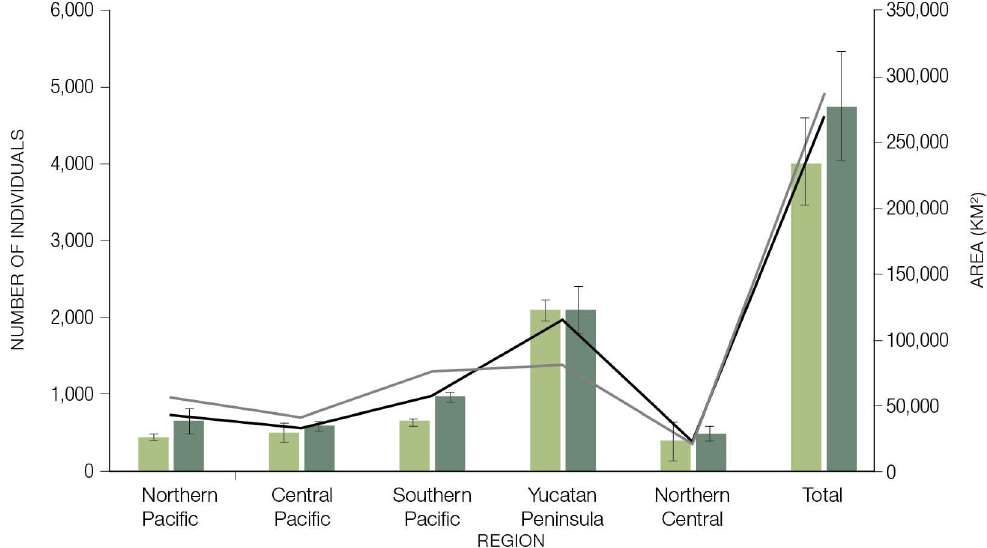
Fig 6. Jaguar population estimates in the 2010 (left bars) and for 2018 (right bars) censuses in Mexico. Suitable habitat available for 2010 (black line) and 2018 (gray line). Note: The population showed a ~20% increase in that period and suitable habitat also increased for four of the five regions and overall